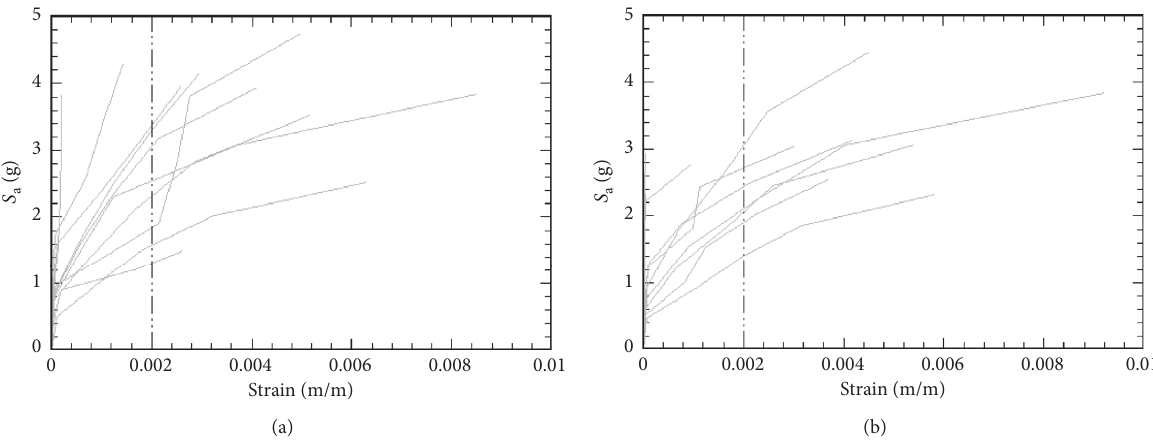
Figure 7: IDA curves considering steel rebar strains as EDP for (a) the long-duration set and (b) the short-duration set.